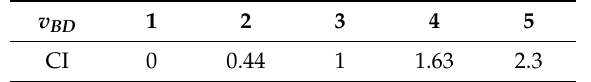
Table 4. The consistency index (CI) values for computing the consistency